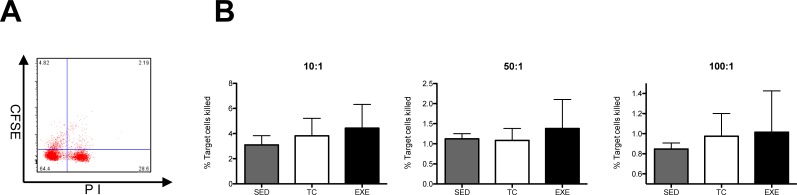
Cytotoxic activity of total splenocytes in vitro.(A) Representative dot plot of cytometric analysis of killed target cells percentage. (B) Cytotoxic activity of total splenocytes was assessed in vitro at three different ratios (effector cells: target cells, 10:1, 50:1 and 100:1); data from 2 independent experiments are expressed as mean ± SE, with an n = 6 for each condition. No differences were found among the groups at any of the different ratios. In bar graphics SED is represented by the shaded bar, TC by the white bar and EXE by the solid bar.